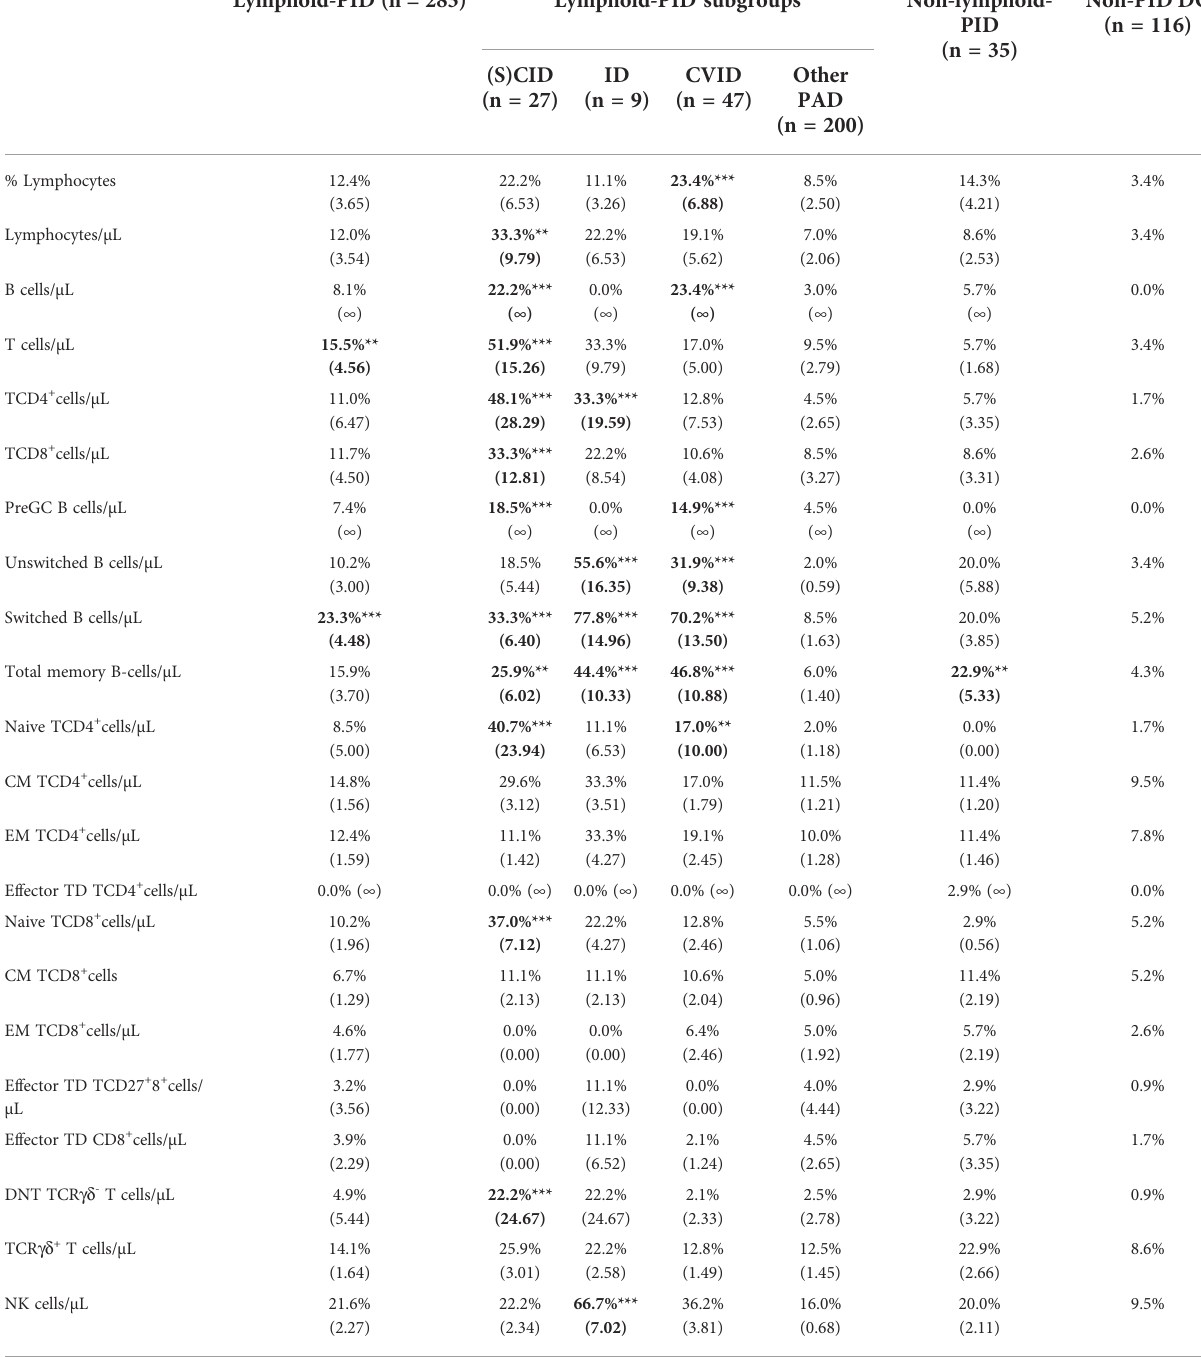
TABLE 3 Comparison of percentage of patients with numerical lymphoid defects identi fi ed per lymphoid subpopulation for PID (sub)groups with the non-PID disease